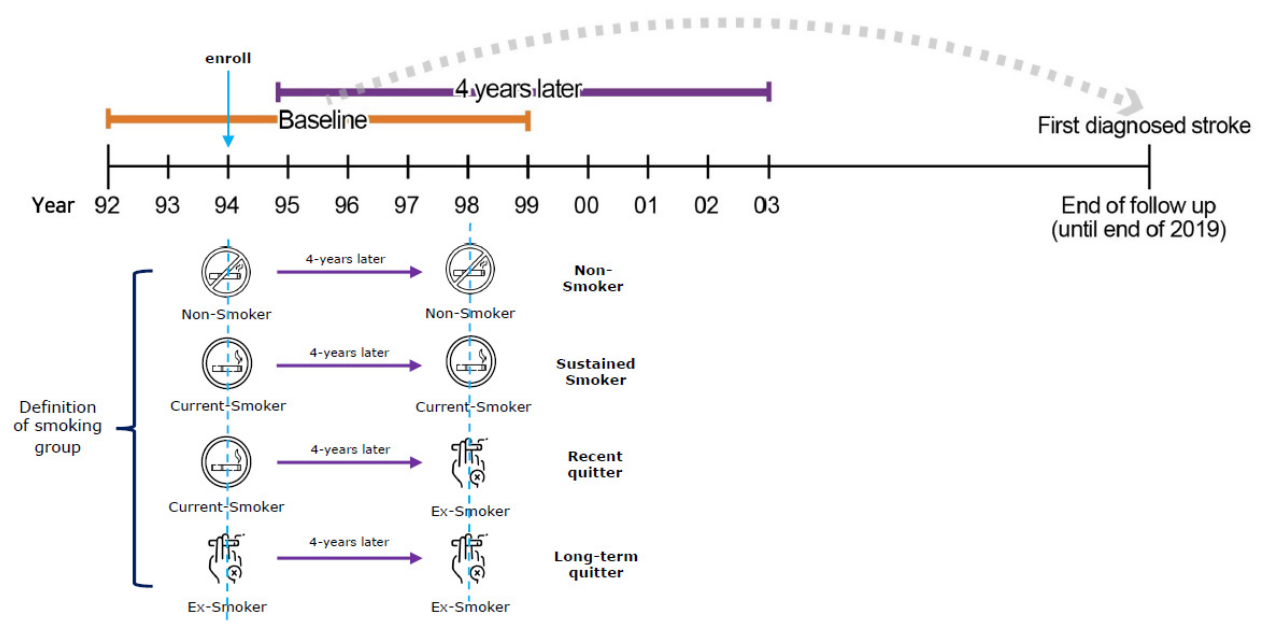
Figure 2. Definition of smoking groups according to smoking status.